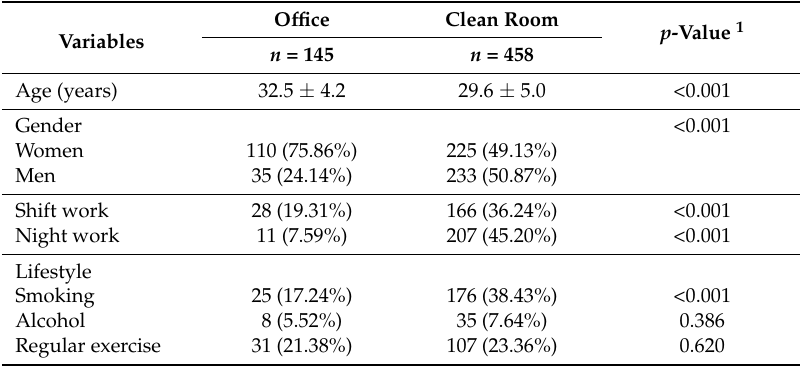
Table 5. Comparison of demographic and employment characteristics between office workers and clean room workers.